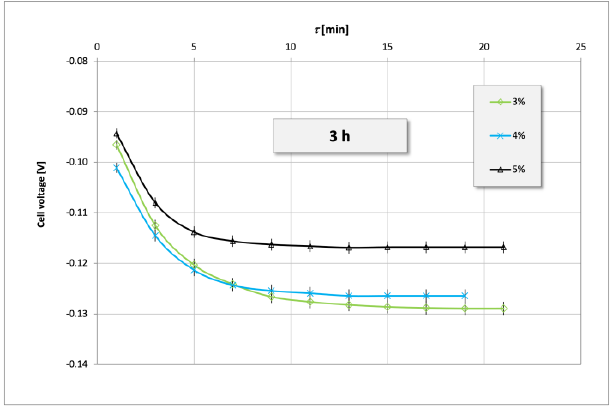
Figure 3. Cu-Ag cathode oxidized for 3 h — the electroless potential of cathode.